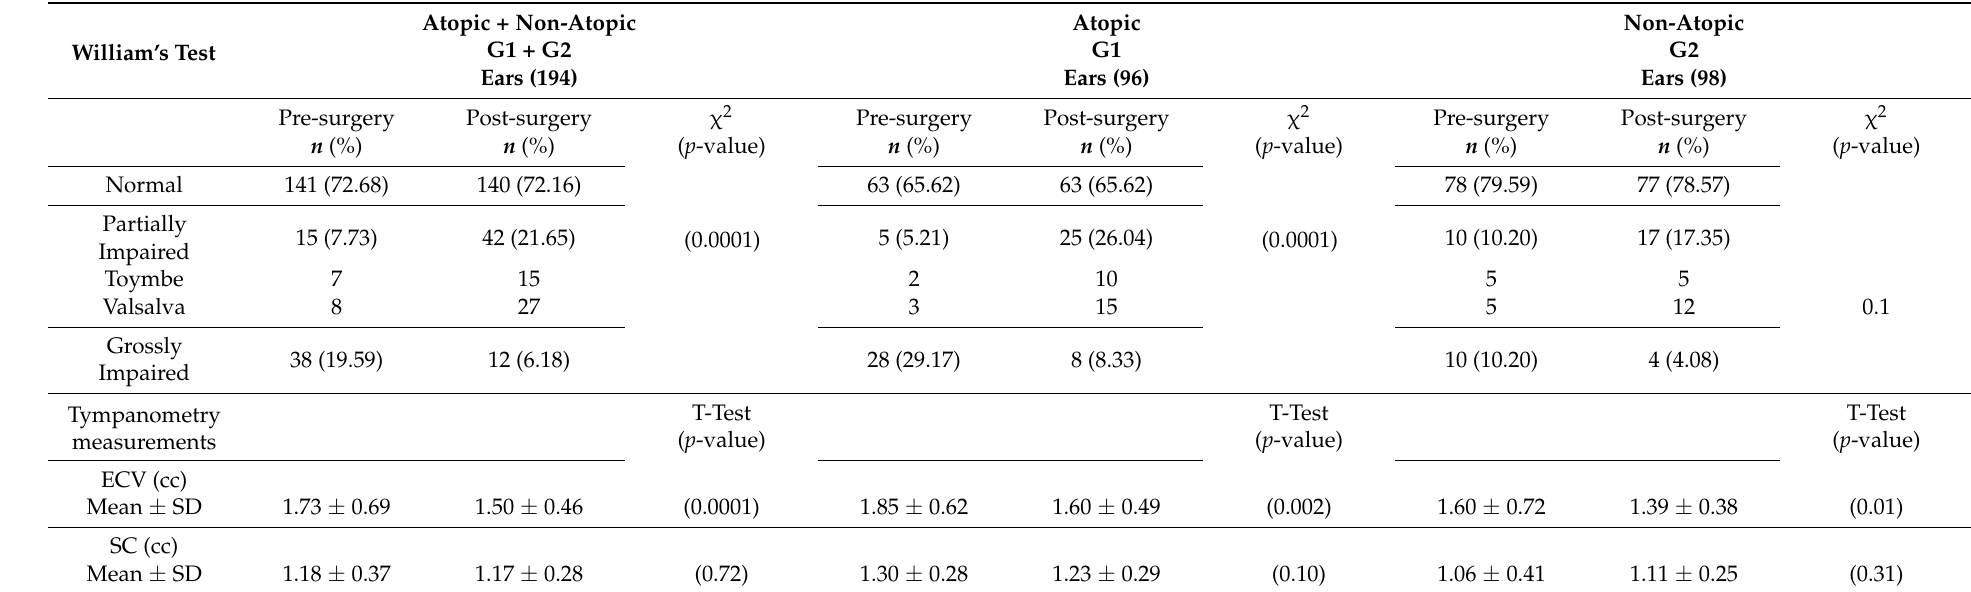
Table 2. William’s test and tympanometry measurements before and after